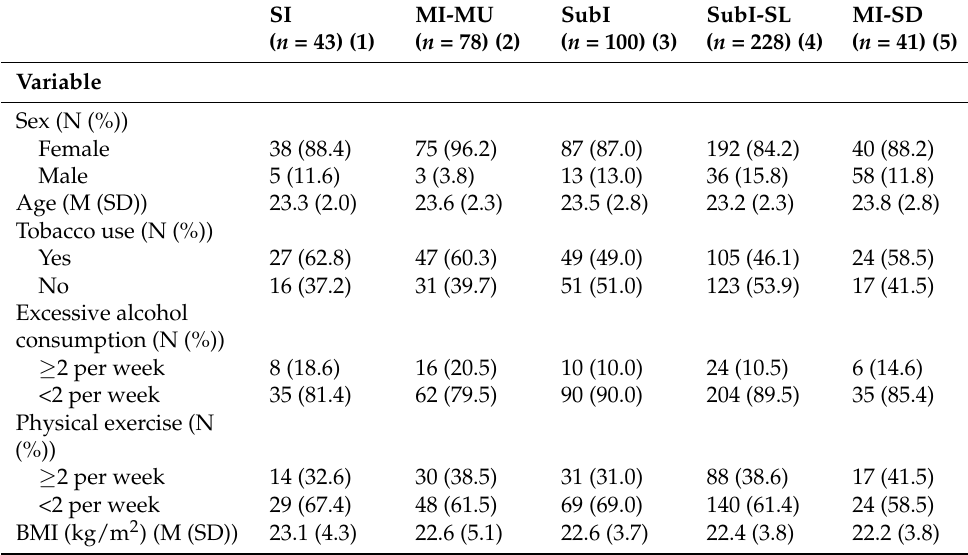
Table A1. Demographic and health-related characteristics of participants in the five identified insomnia profiles.